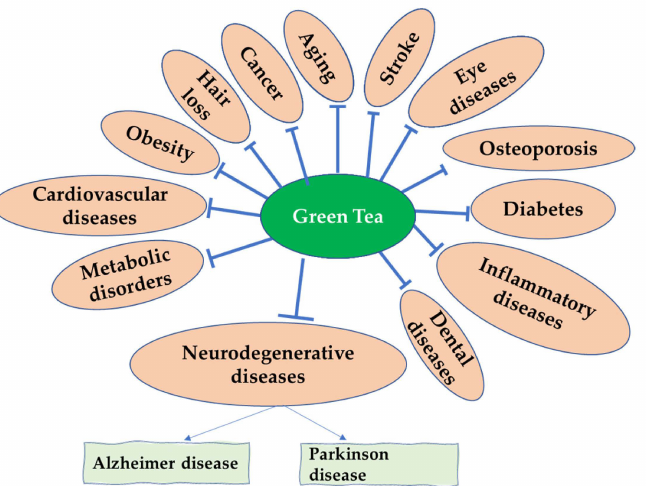
Figure 3. Medicinal Properties of Green Tea polyphenols. Extensive research has shown that green tea polyphenols exhibit anti-inflammatory, antioxidative, and anti-microbial attributes, preventing or alleviating many terminal diseases, such as cardiovascular disease, neurodegenerative diseases, and osteoporosis.